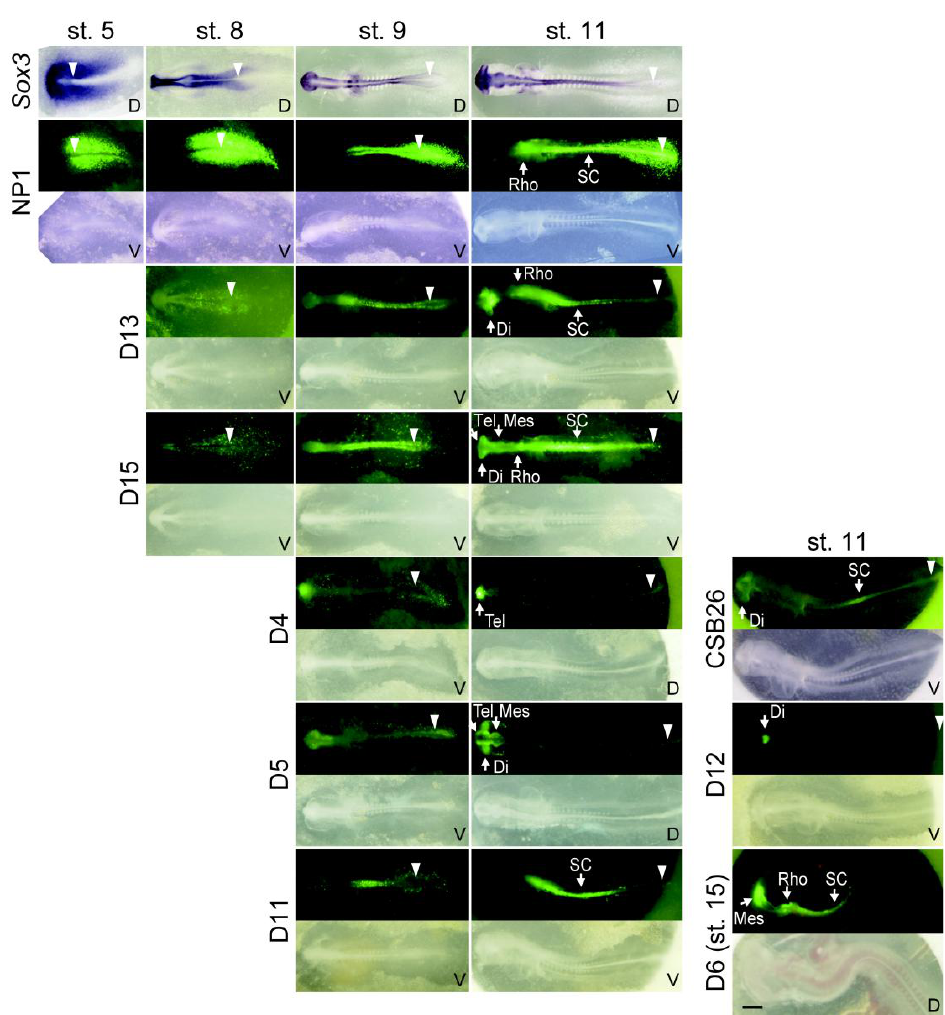
Figure 4. Sequential activation of Sox3 enhancers that show distinct tissue specificities in the neural primordia. The D1 activity was represented by the NP1 enhancer sequence (see also Figure 5C). The top row: Sox3 in situ hybridization patterns in chicken embryos at respective developmental stages. Other rows, EGFP expression reflecting the specificity of the enhancers in comparison with the bright-field image of the same embryo. The data of an enhancer at different developmental stages was taken from the same embryo. V, ventral (cid:89)(cid:76)(cid:72)(cid:90)(cid:30)(cid:3) (cid:39)(cid:15)(cid:3) (cid:71)(cid:82)(cid:85)(cid:86)(cid:68)(cid:79)(cid:3) (cid:89)(cid:76)(cid:72)(cid:90)(cid:17)(cid:3) (cid:55)(cid:75)(cid:72)(cid:3) (cid:90)(cid:75)(cid:76)(cid:87)(cid:72)(cid:3) (cid:87)(cid:85)(cid:76)(cid:68)(cid:81)(cid:74)(cid:79)(cid:72)(cid:86)(cid:3) (cid:76)(cid:81)(cid:71)(cid:76)(cid:70)(cid:68)(cid:87)(cid:72)(cid:3) (cid:87)(cid:75)(cid:72)(cid:3) (cid:83)(cid:82)(cid:86)(cid:76)(cid:87)(cid:76)(cid:82)(cid:81)(cid:86)(cid:3) (cid:82)(cid:73)(cid:3) (cid:43)(cid:72)(cid:81)(cid:86)(cid:72)(cid:81)(cid:182)(cid:86)(cid:3) (cid:81)(cid:82)(cid:71)(cid:72)(cid:17)(cid:3) (cid:36)(cid:79)(cid:79)(cid:3) photographs are shown on the same scale. The bar indicates 500 (cid:80) m. Di, diencephalon; Mes, mesencephalon; Rho, rhombencephalon; SC, spinal cord; Tel,